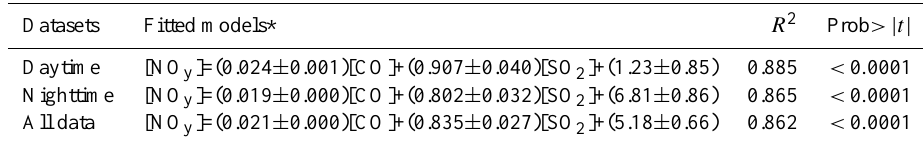
Table 3. Results of multiple linear regressions of NO y with CO and SO 2 for different datasets.